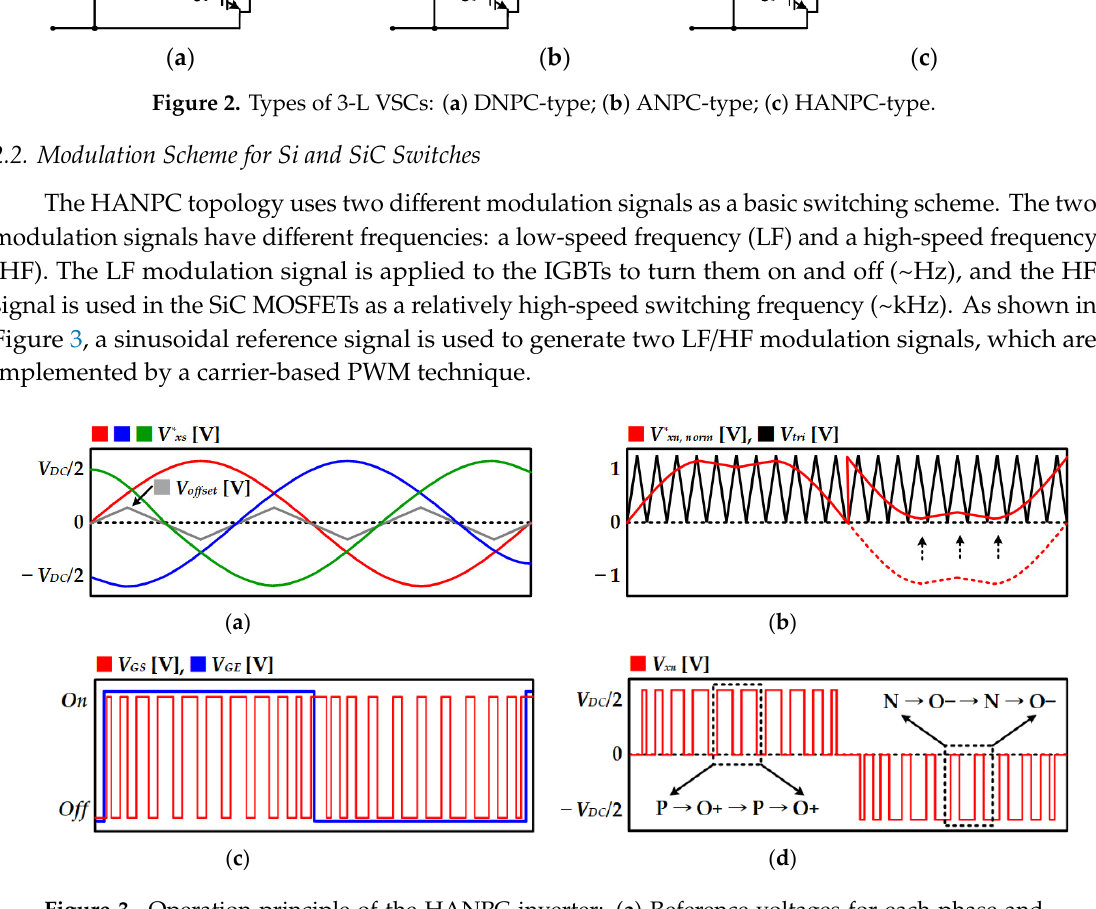
Figure 3. Operation principle of the HANPC inverter: ( a ) Reference voltages for each phase and common offset voltage; ( b ) Normalized reference voltage and triangular carrier wave; ( c ) Gate signals for Si IGBTs and SiC MOSFETs; ( d ) Three-level output pole voltage.